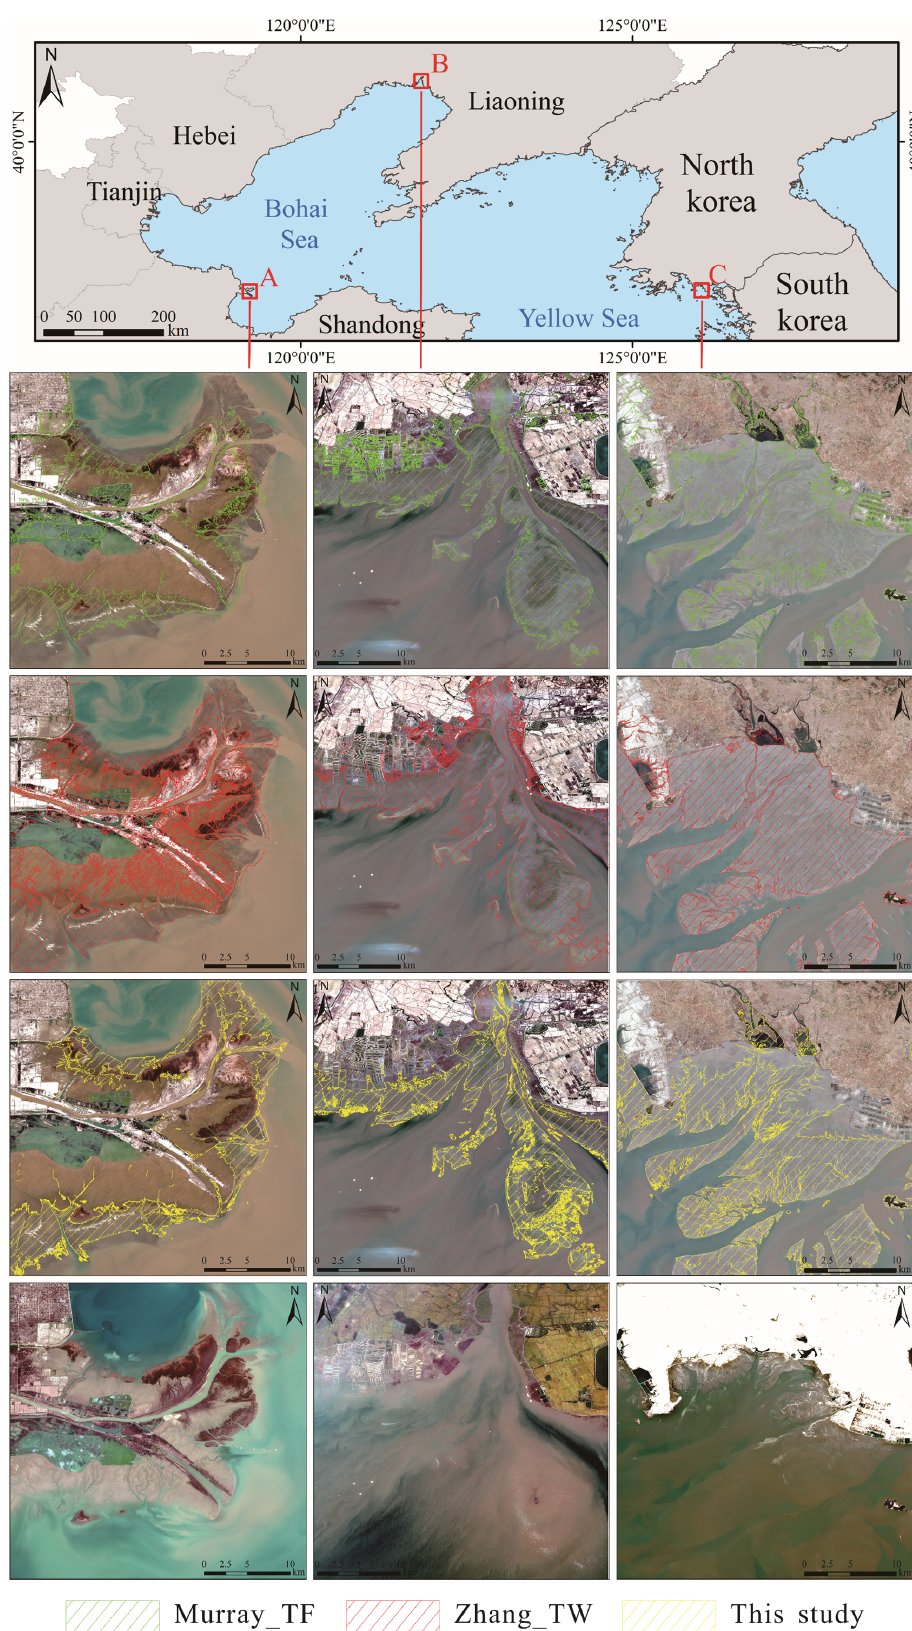
Figure 8. Exhibition of tidal flats range from the Murray_TF [1], our result (”This study”), and tidal wetlands range from Zhang_TW [10] in the Yellow river delta (region A), Liao Estuary (region B)